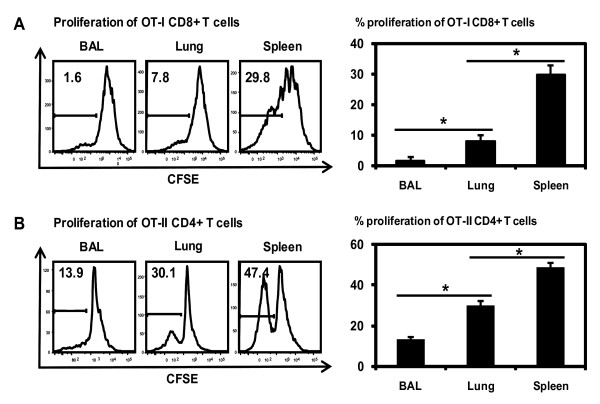
Antigen-specific transgenic T cell activation by peptide-pulsed CD11c+ APCs from BAL, lung parenchyma and spleen. CD11c+ APC populations isolated from BAL, lung and spleen were pulsed with OVA OT-I (SIINFEKL) or OT-II peptide and co-cultured for 48 hours with CFSE-labelled OT-I CD8+ T cells or for 72 hours with CFSE-labelled OT-II CD4+ T cells. Transgenic T cell proliferation was analyzed by FACS. A, OT-I CD8 T cell proliferation. B, OT-II CD4 T cell proliferation. Representative histograms of T cell proliferation are shown. The average T cell proliferation rates are shown in bar graphs after subtracting from appropriate controls. Results are presented as mean ± SD of triplicate samples. *p < 0.05.